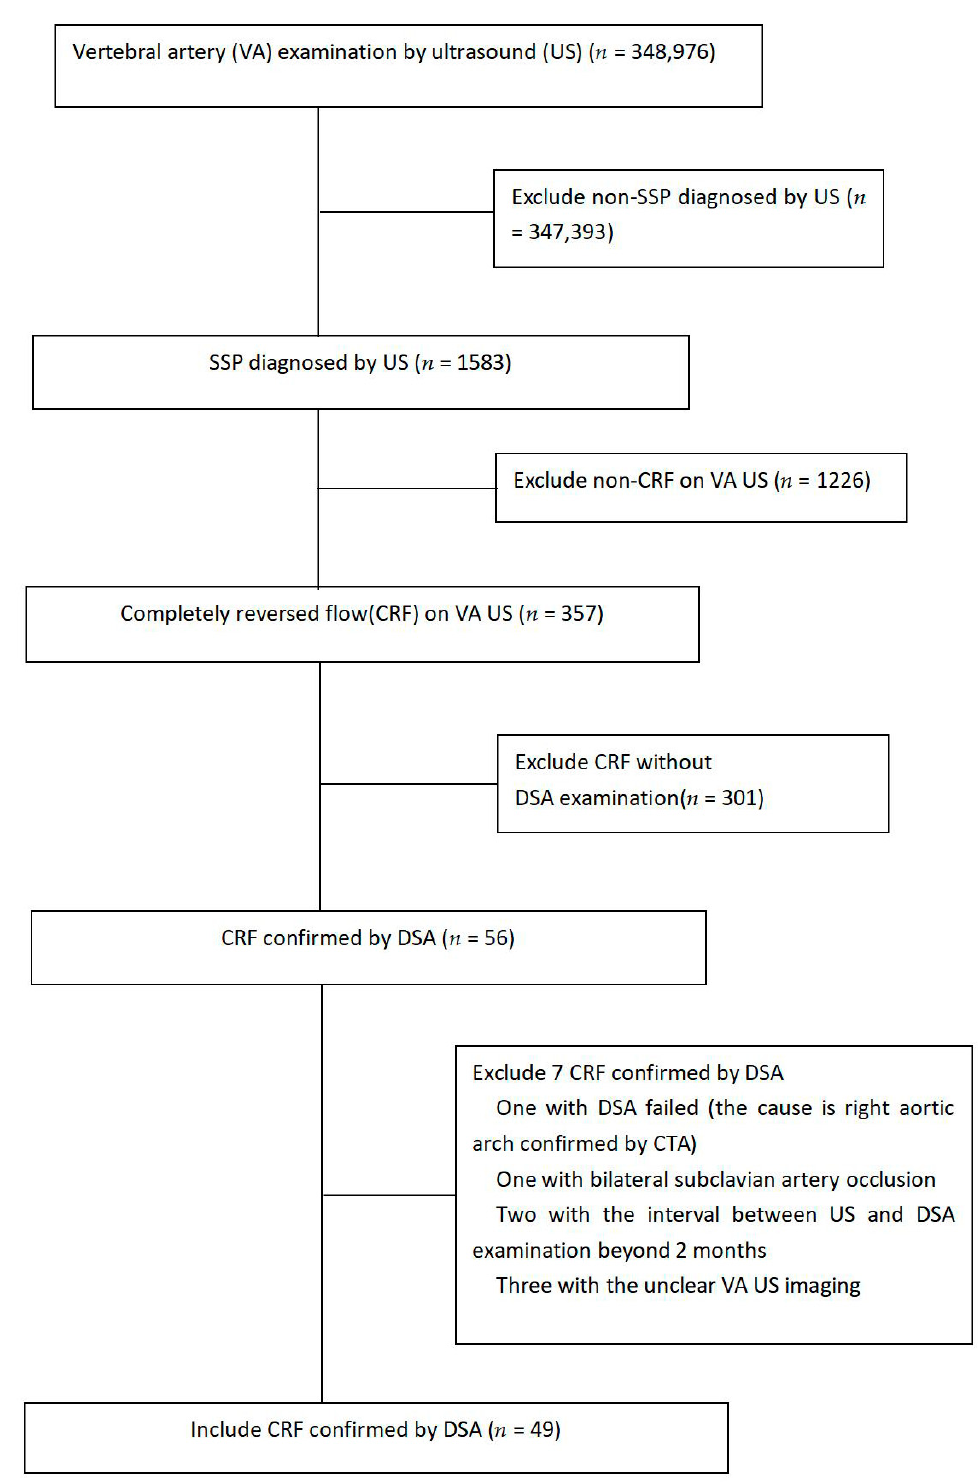
Figure 1. Flowchart of criteria for patient selection. VA, vertebral artery; US, ultrasound; SSP, subclavian steal phenomenon; CRF, completely reversed flow; DSA, digital subtraction angiography; CTA, computer tomography angiography.